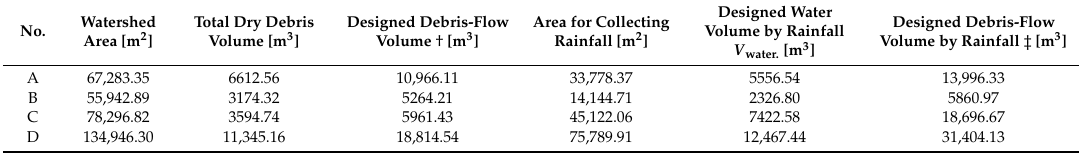
Table 2. Information of watershed area and total volume of debris in each